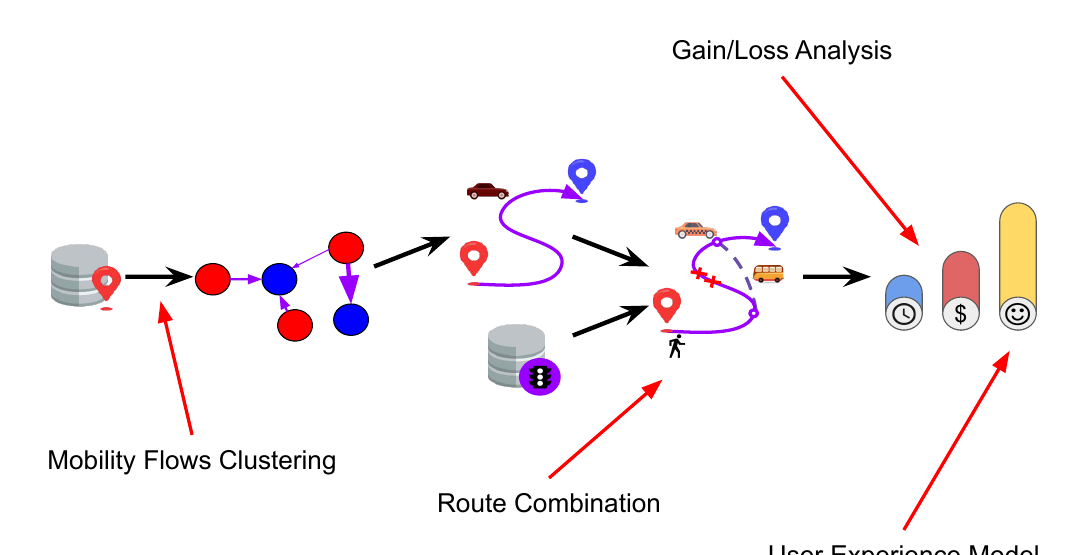
Figure 1. Overview of proposed